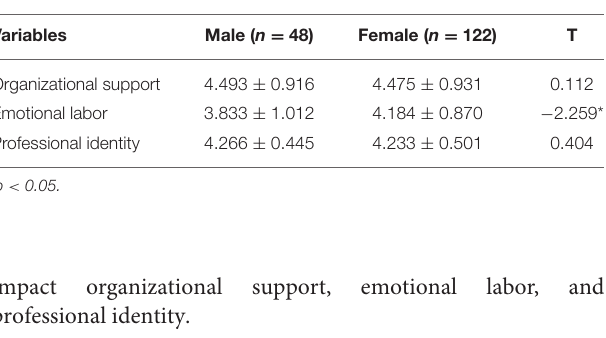
TABLE 2 | Results of the t -test of independent samples based on gender